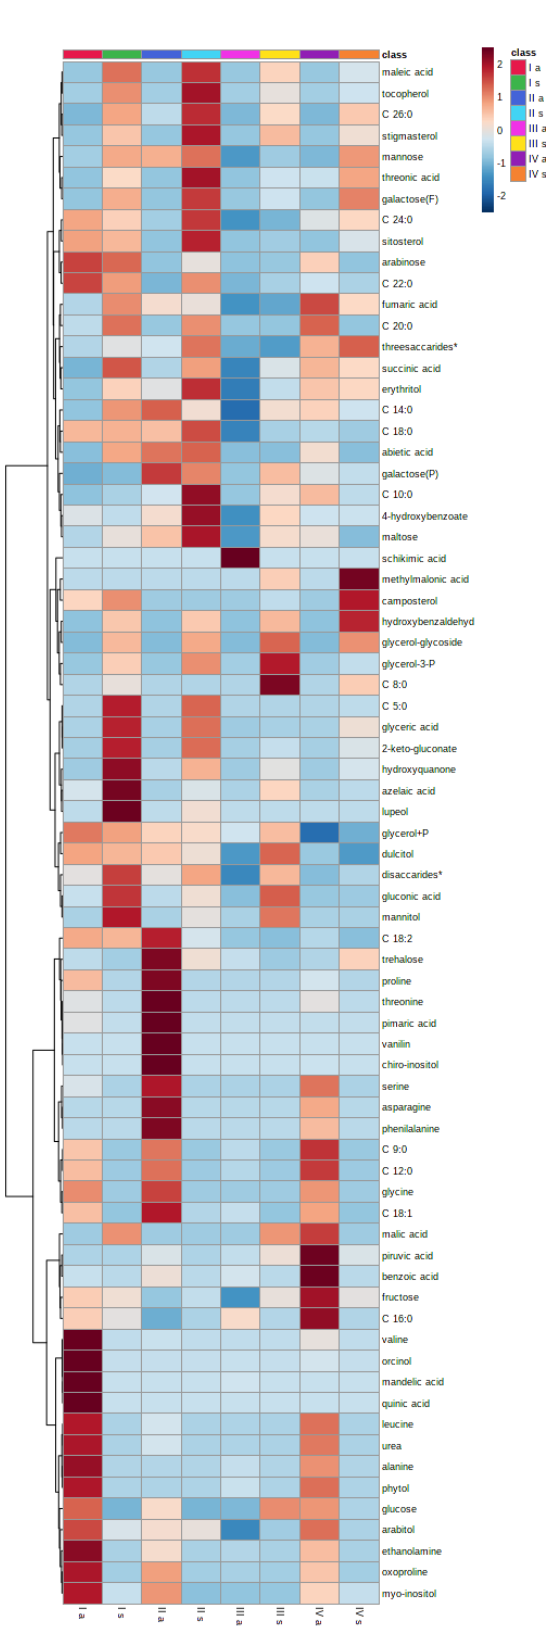
Figure 9. Heat maps of united spring-summer and autumn metabolome data of biolayers from Ruskeala quarry (group average shown). Notes: a — autumn samples, s — spring-summer samples, * — summarize concentration, P — pyranose, F — furanose.